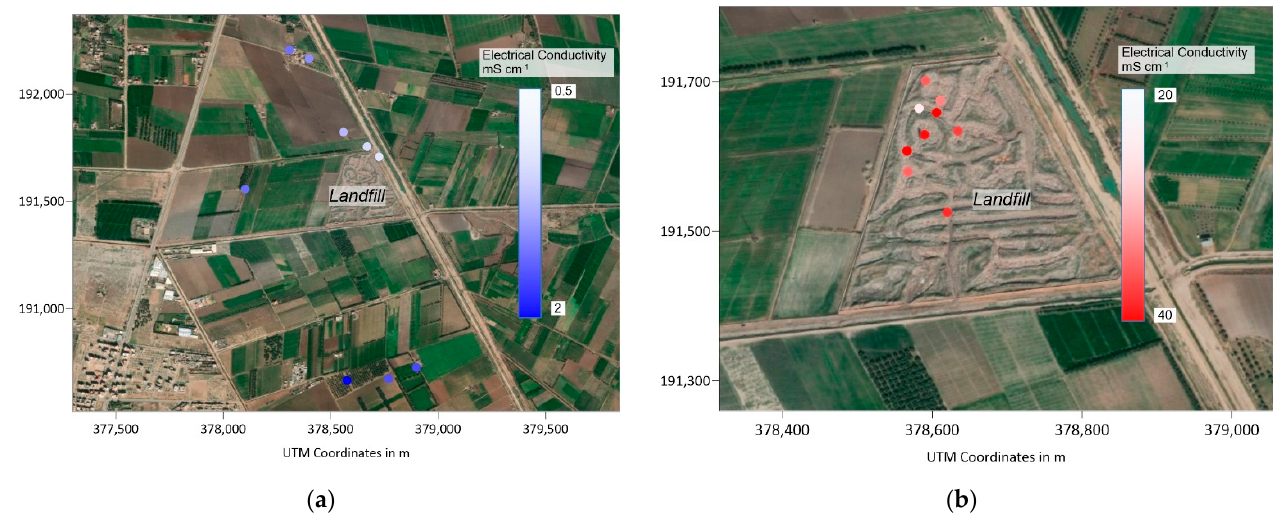
Figure 6. Distribution of electrical conductivity ( a ) in the watertable, and ( b ) in the leachates.